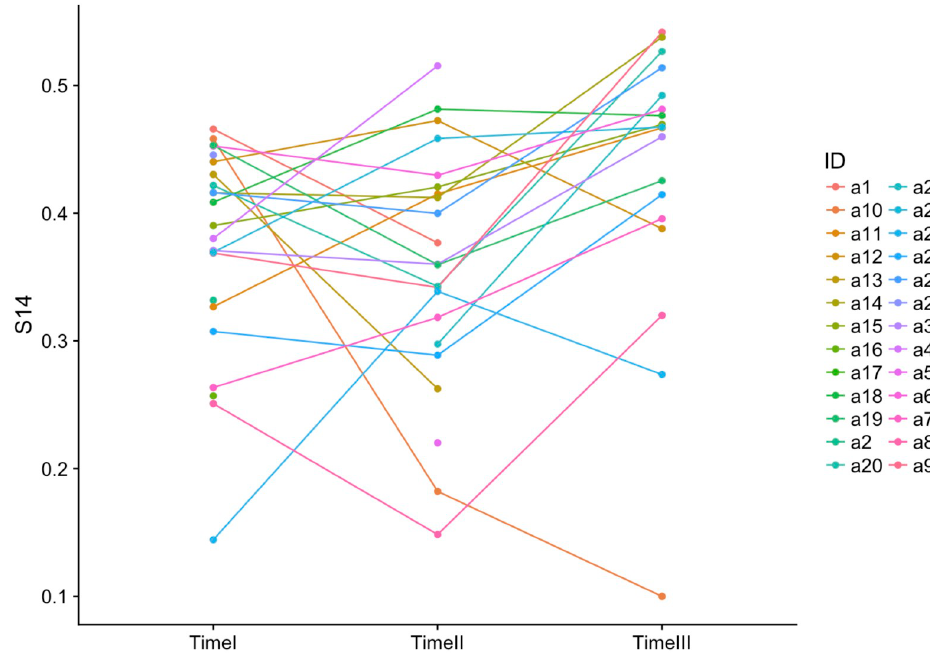
Fig 3. Accuracy over time per